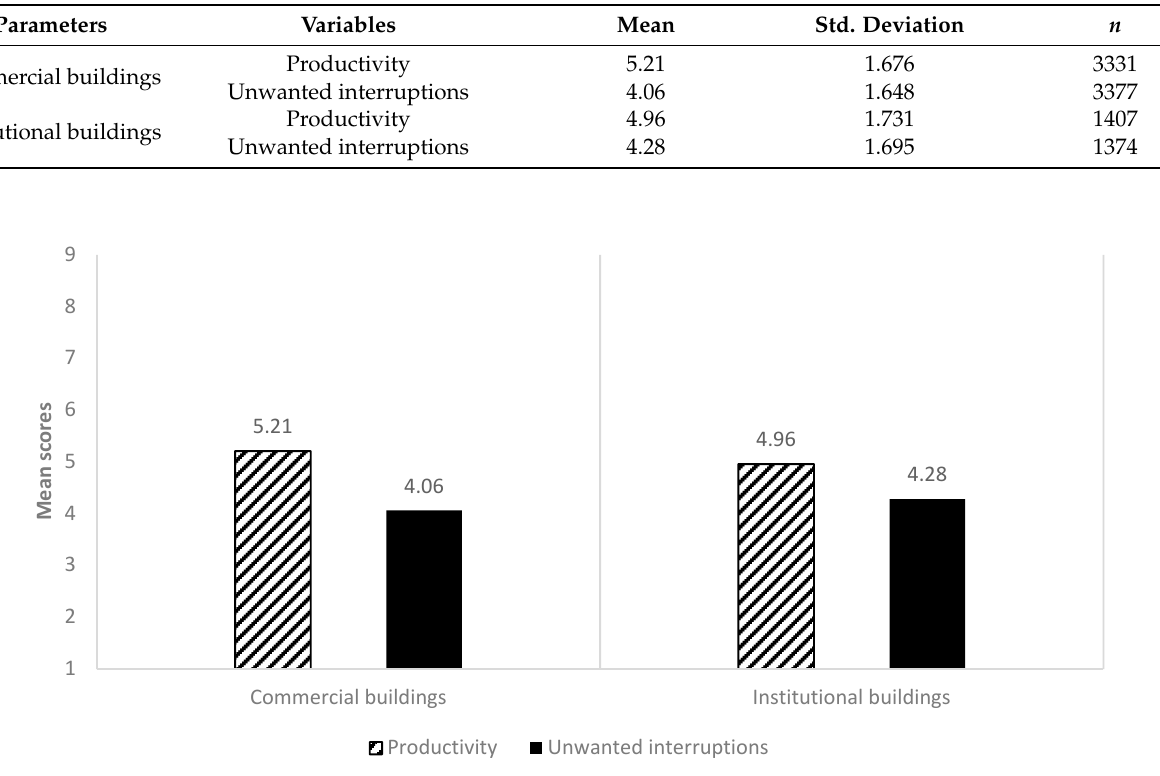
Figure 2. Comparative analysis of mean scores of productivity and unwanted interruptions between commercial and institutional buildings. Table 4. Descriptive statistics of productivity and unwanted interruptions in commercial and institutional buildings.